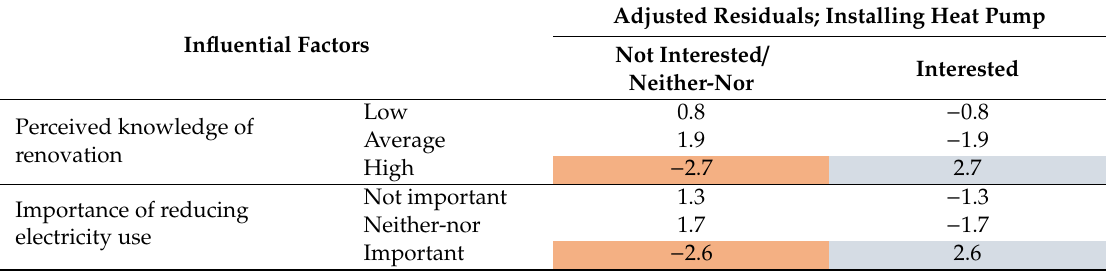
Table A5. Post-hoc analyses of influential factors on homeowners’ interest to install heat